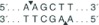
Recognition sequence of
HindIII enzyme.The authors confirm that this is an original image and has not been re-used or adapted from another source.